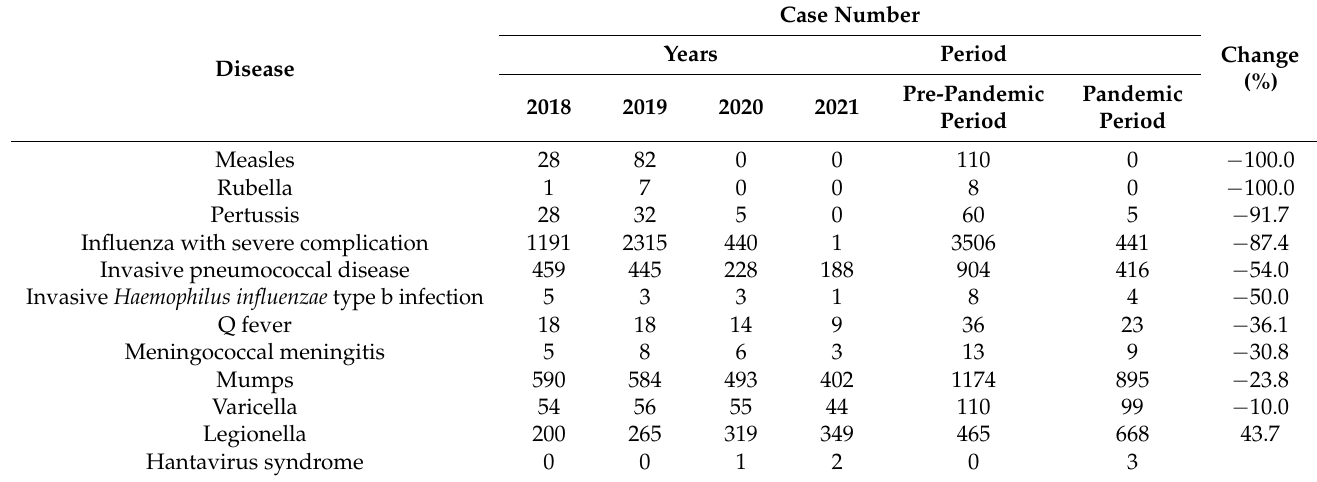
Table 2. The case number of domestic airborne/droplet-transmitted notifiable infectious diseases.